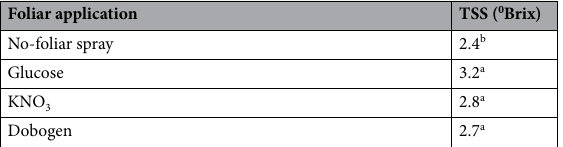
Table 3. Mean comparisons for the effects of 2 g L −1 glucose, 2 g L −1 KNO 3, and 2% Dobogen foliar application on TSS content of Tanacetum balsamita plants grown hydroponically in perlite. Significant differences among salinity treatments are indicated by the different Latin letters according to Duncan’s multiple range test.